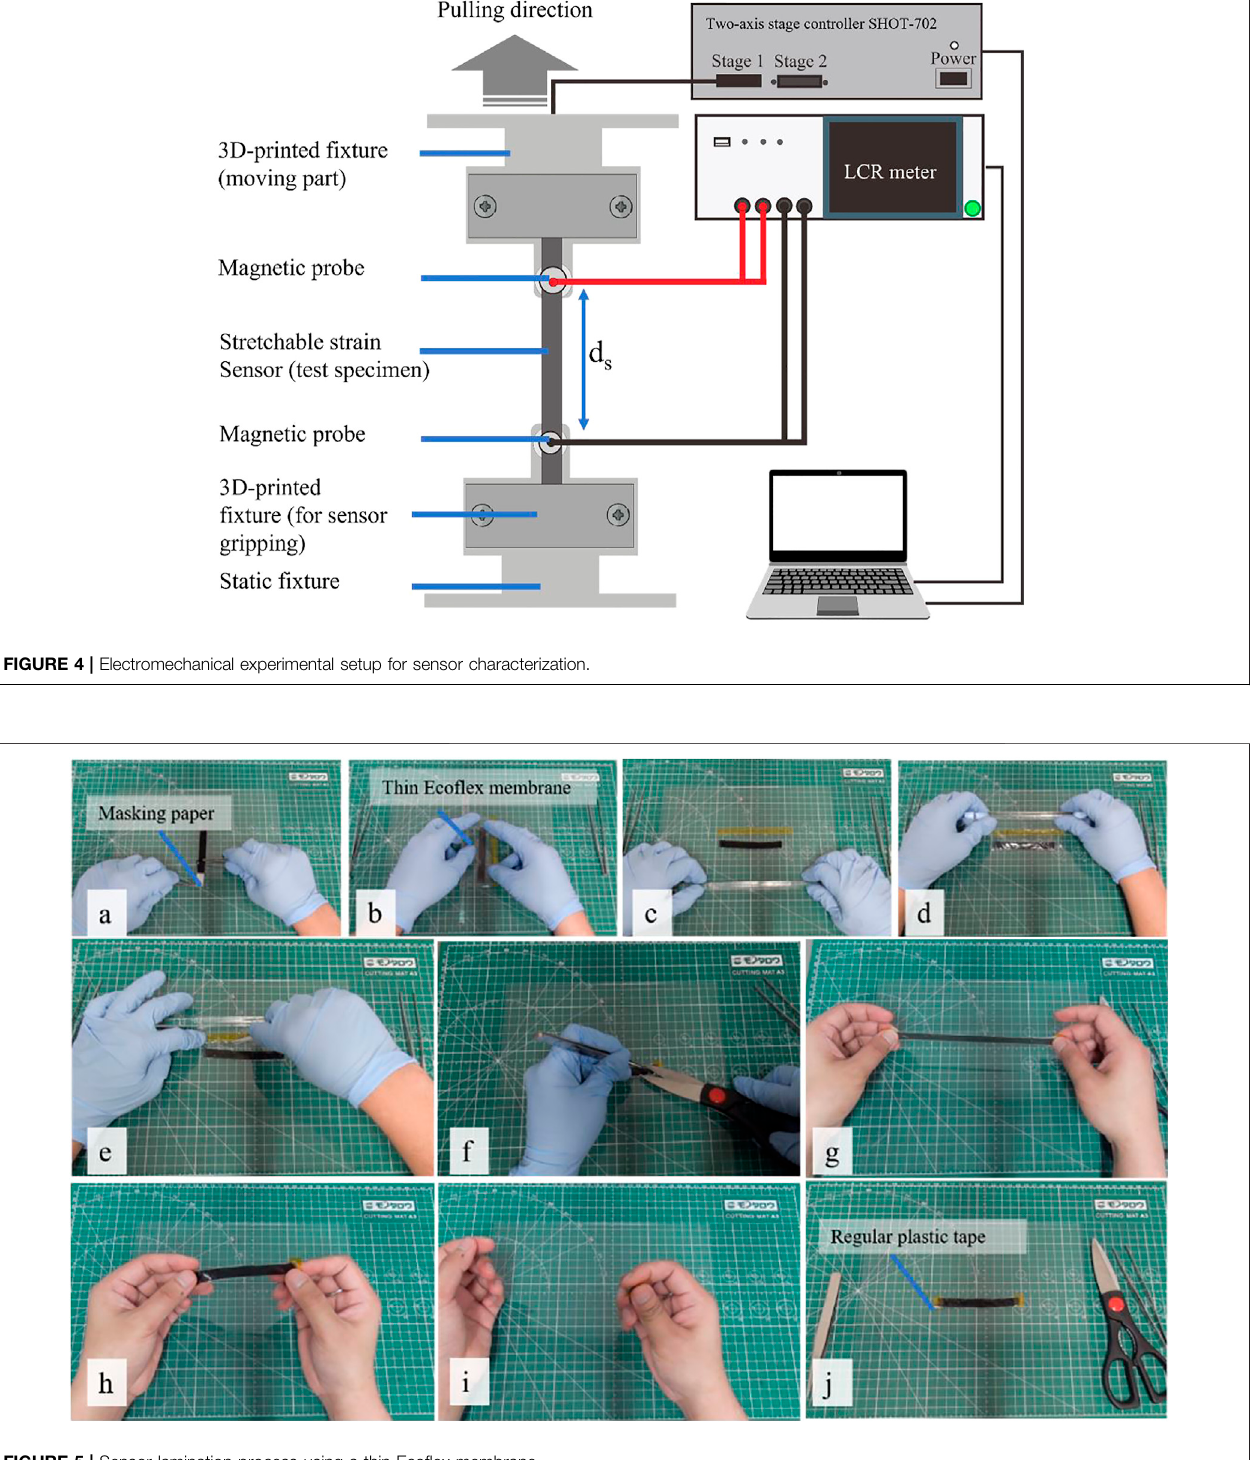
Frontiers in Robotics and AI |